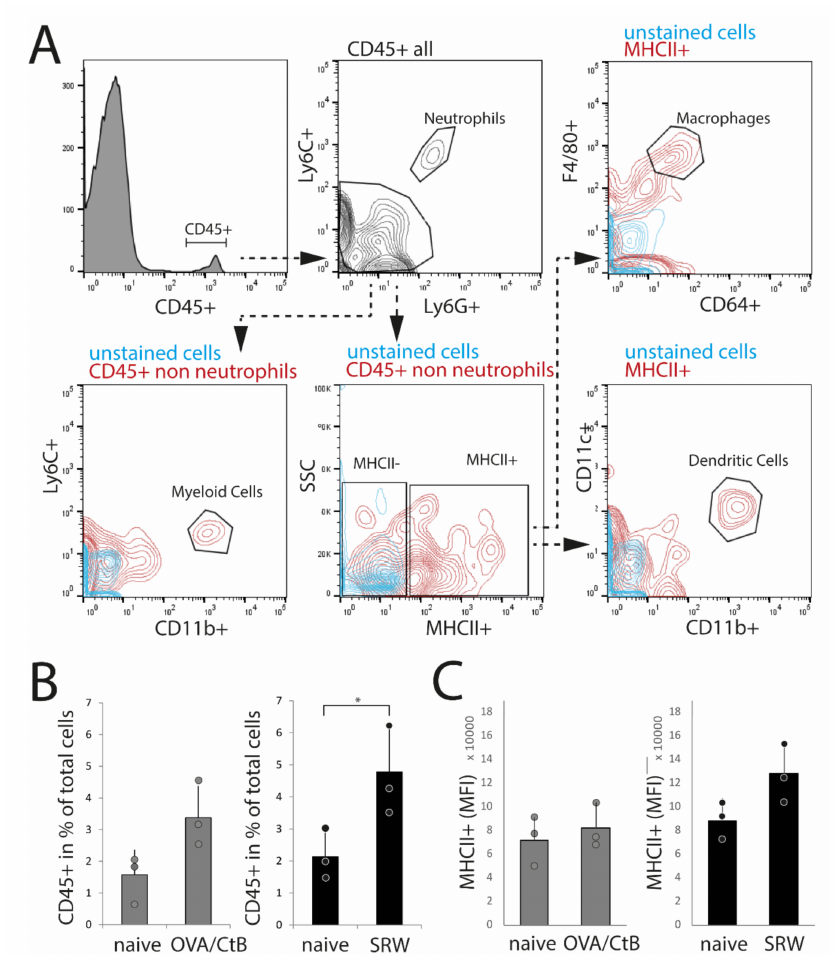
Figure 3. Flow cytometry analysis of isolated nictitating membrane tissues (CALT). ( A ) Gating strategy. ( B ) After SRW stimulation, the number of CD45 + cells was increased compared to naïve mice, reflecting the increased number and size of CALT. In OVA / CtB stimulated mice, the number of CD45 + cells was increased by trend ( p = 0.07). ( C ) Median fluorescence intensity (MFI) of MHC II + cells within the CD45 + non-neutrophils gate. No di ff erences were found. ( n = 3 independent experiments, n = 5 mice pooled / sample; * p <